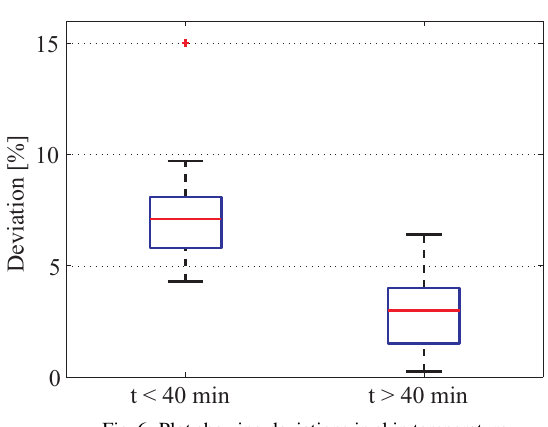
Fig.6: Plot showing deviations in skin